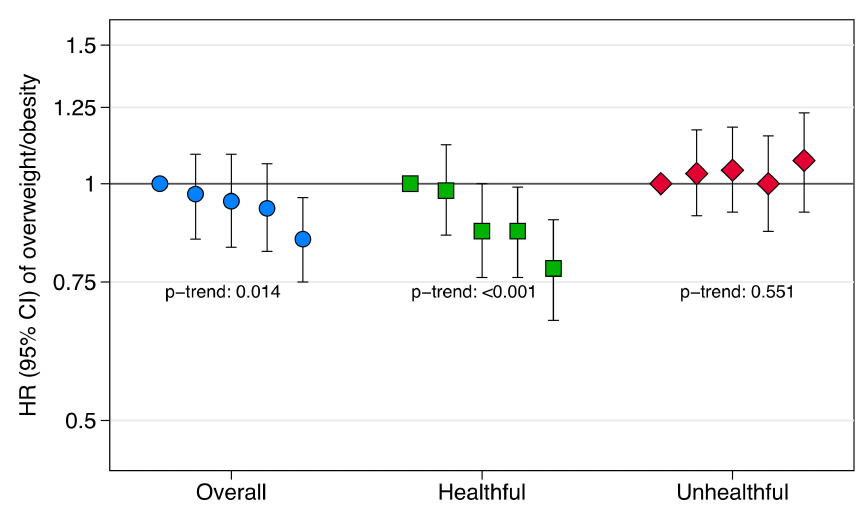
Figure 2. Hazard ratios (HR) and 95% confidence intervals (CI) of overweight / obesity according to baseline quintiles of the provegetarian food